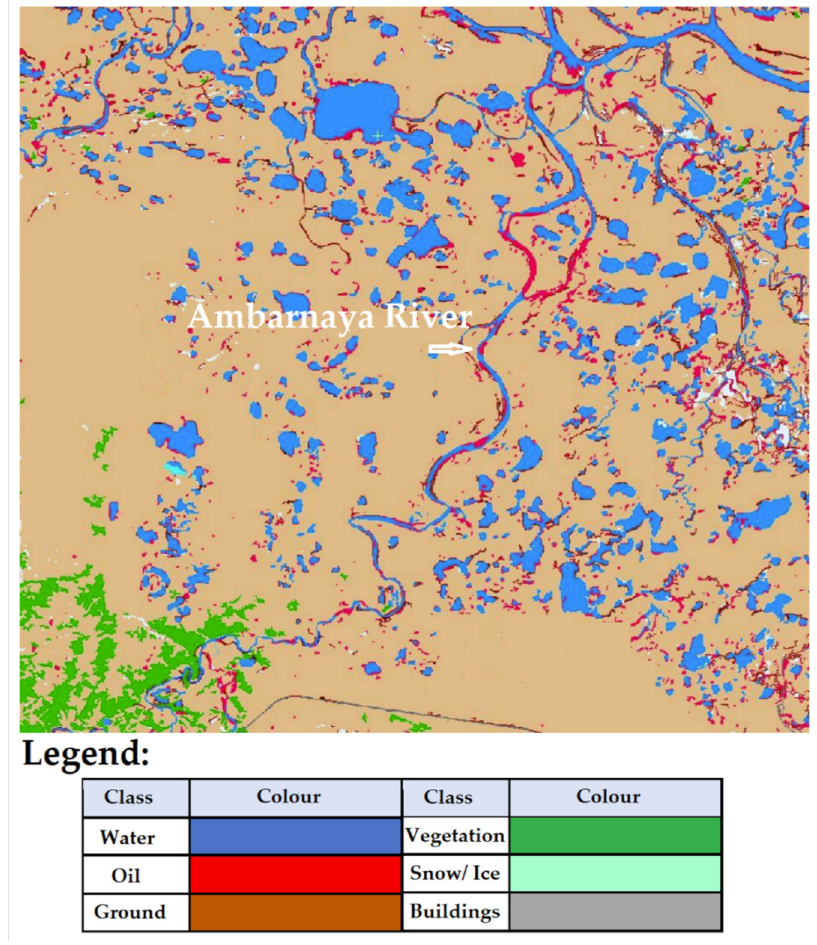
Figure 6. SVM Classification results.